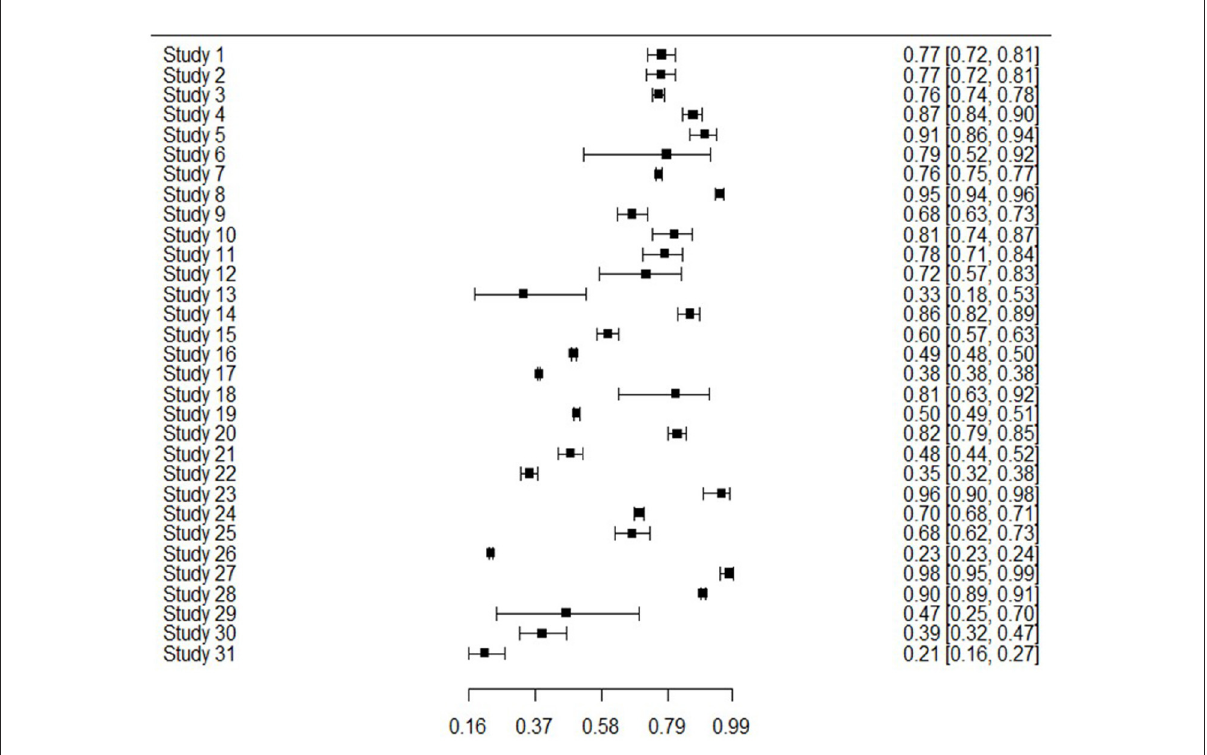
FIGURE2 Forest plot of sensitivity and CI for 31